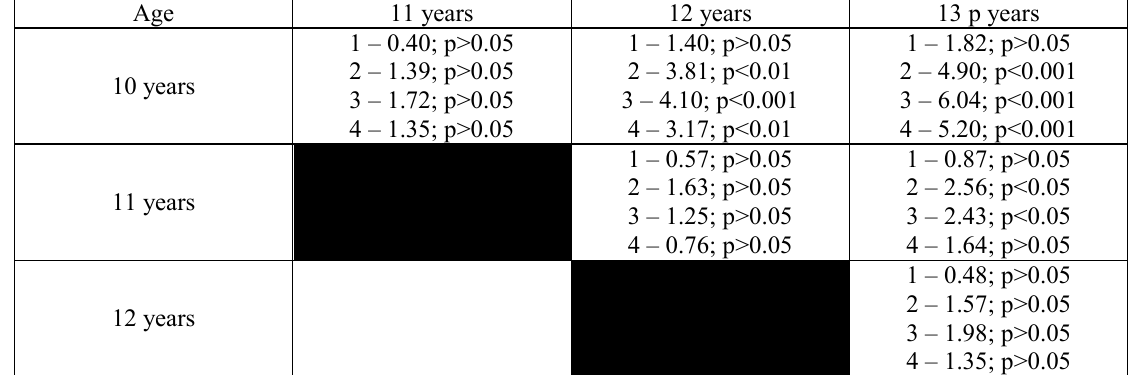
Matrix of indices changes reliability of shuttle run 4×9 m of boys aged 10-13 from different groups (n 1 =n 2 =n 3 =n 4